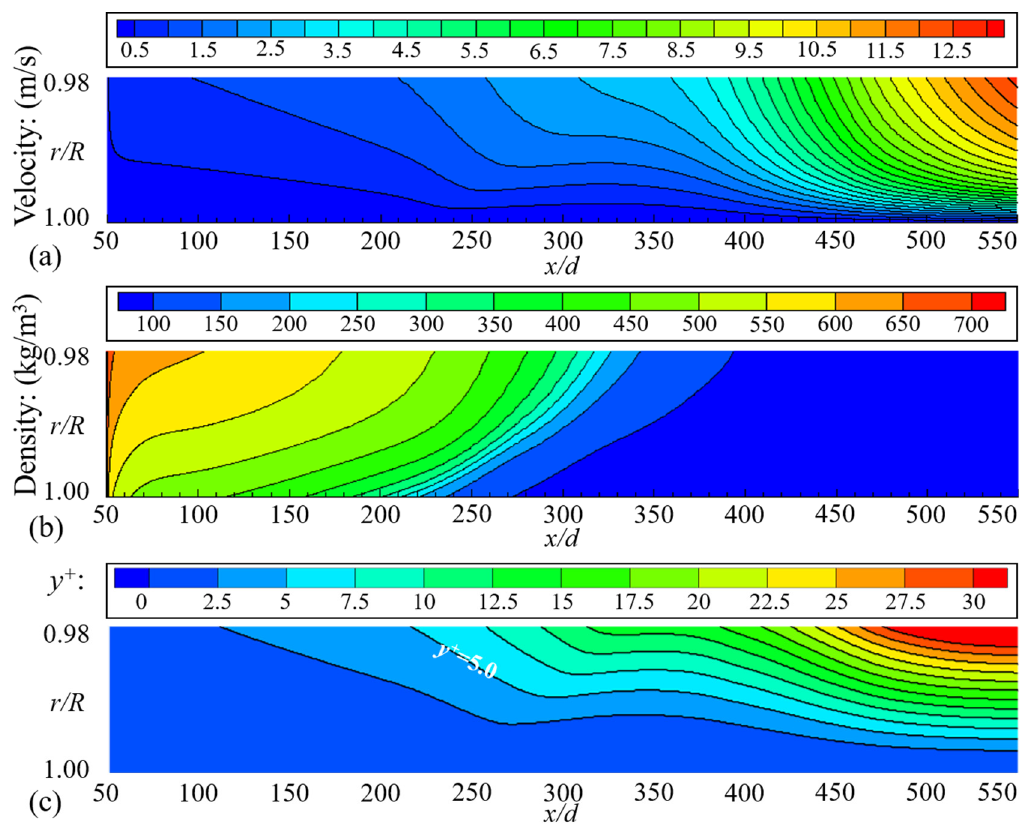
Figure 9. Near-wall flow field: ( a ) velocity distribution near heated wall; ( b ) density distribution near to heated wall; ( c ) distribution of y + .